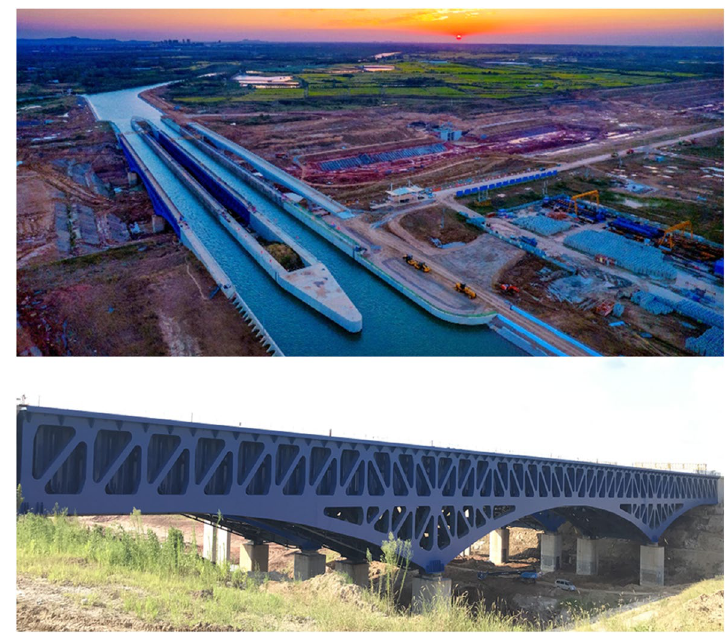
Fig. 5 The world’s longest-span navigable aqueduct bridge: the Pi River Bridge